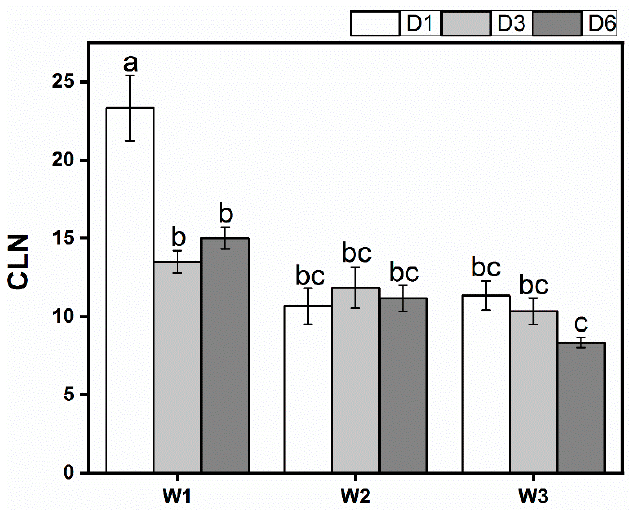
Figure 4. CLN at the end of the experiment in R. pseudoacacia subjected to different rainfall intensity and rainfall frequency treatments (mean ± SE, n = 6). Different letters within the same column denote significant differences at p ≤ 0.05 according to Tukey’s − HSD test. W1, W2, and W3: 75%, 55%, and 35% of field capacity, respectively. D1, D3, and D6: every day, every 3 days, and every 6 days of watering, respectively.